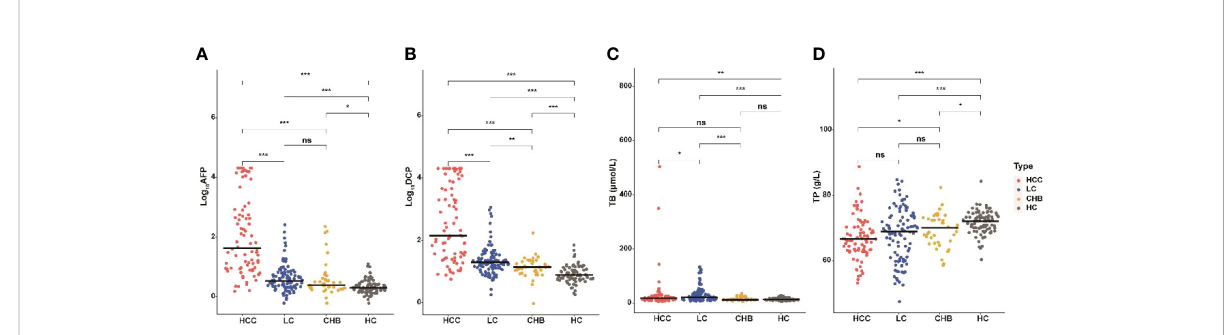
FIGURE 1 Serum AFP, DCP, TB and TP in HCC and non-HCC groups. Comparison of AFP (A) , DCP (B) , TB (C) , and TP (D) among HCC, LC, CHB, and HC groups. The horizontal bar represents median values. Characteristics differences were tested using Wilcoxon test. ns P >0.05, * P < 0.05, ** P < 0.01, *** P < 0.001. HCC, hepatocellular carcinoma; LC, liver cirrhosis; CHB, chronic hepatitis B; HC, healthy controls; TP, total protein; TB, total